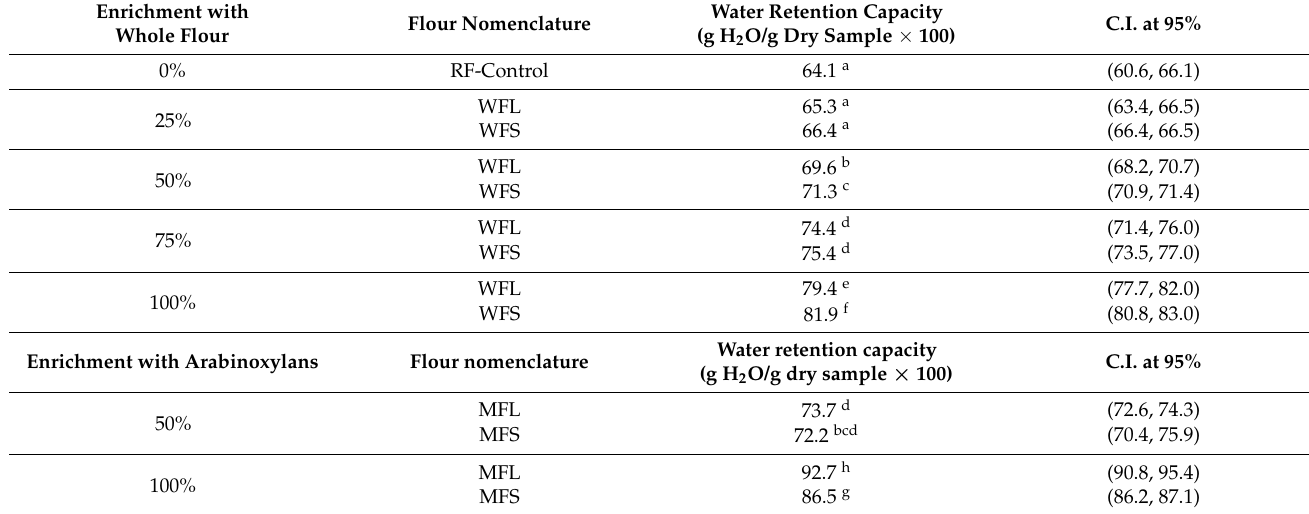
Table 1. Water retention capacity (expressed as g H 2 O/g dry sample × 100) measured in the refined flour (RF-Control), in the blends prepared by replacing 25, 50, 75 or 100% of the refined flour with whole flour with coarse bran (WFL) or whole flour with fine bran (WFS), and in model flours enriched with arabinoxylans with an equivalent content to that found in flours with 50 or 100% whole flour replacement (MFL: coarse bran; MFS: fine bran). Data are observed means ± confidence intervals (C.I.) at 95%. Different superscripts in “water retention capacity” column denote significant differences ( p <